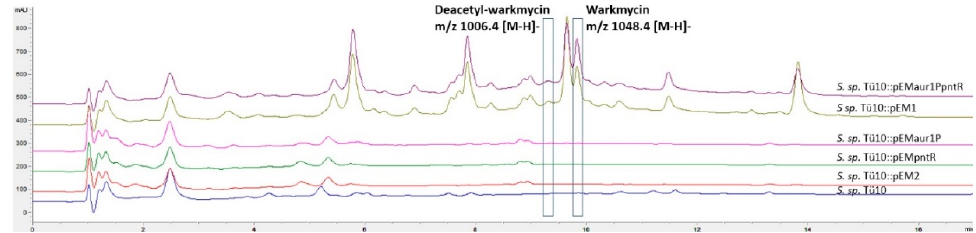
Figure 5. HPLC/MS analysis of the extracts of S. sp. TÜ10 wild type and recombinant strains. Extracts (1 mL ethylacetate extract was evaporated and dissolved in 100 µL methanol) of S. sp. TÜ10::pEMaur1P, S. sp. TÜ10::pEMpntR and S. sp. TÜ10::pEMaur1PpntR, S. sp. TÜ10::pEM1, S. sp. TÜ10::pEM2, S. sp. TÜ10 were analysed via HPLC/MS. A peak with m/z 1048.4 [M+H] + , corresponding to warkmycin and a peak with m/z 1006.4 [M+H] + corresponding to deacetyl-warkmycin, were only detected in the recombinant strains S. sp. TÜ10::pEM1 and S. sp. TÜ10::pEMaur1PpntR .